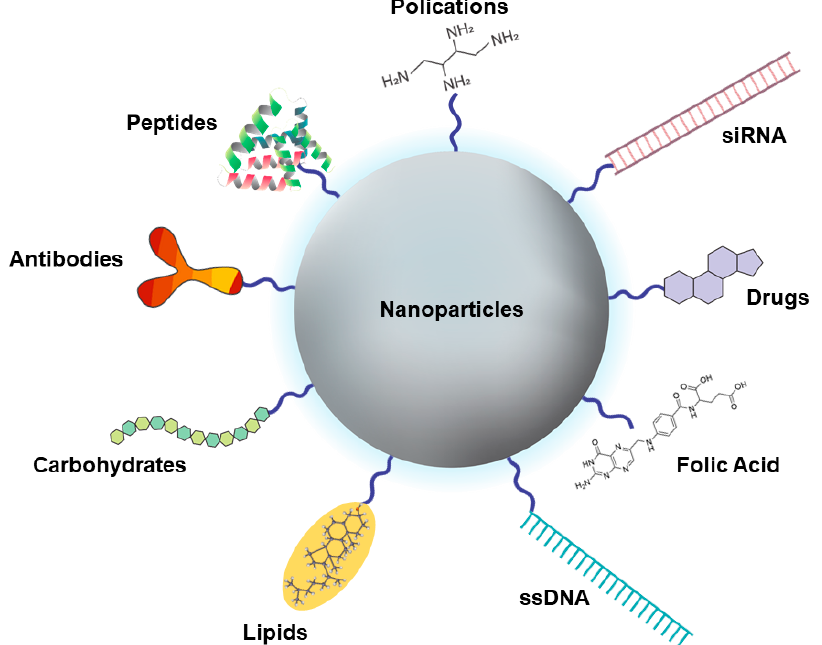
Figure 5. Delivery strategies for the active targeting of NPs. Graphical representation of surface-modified NPs with tar- geting molecules (antibodies, peptides, lipids and carbohydrates) for the delivery of cancer drugs.